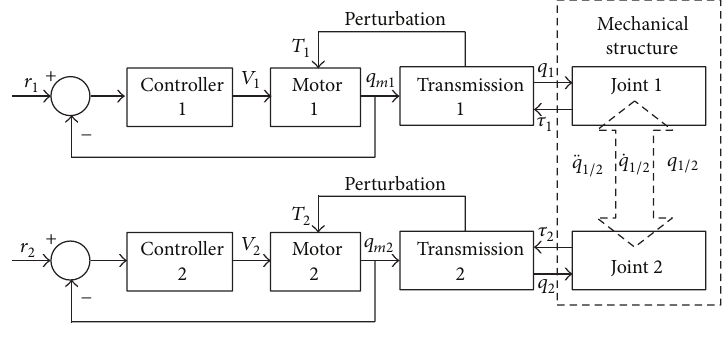
Figure 3: The basic block scheme of the tracking system.